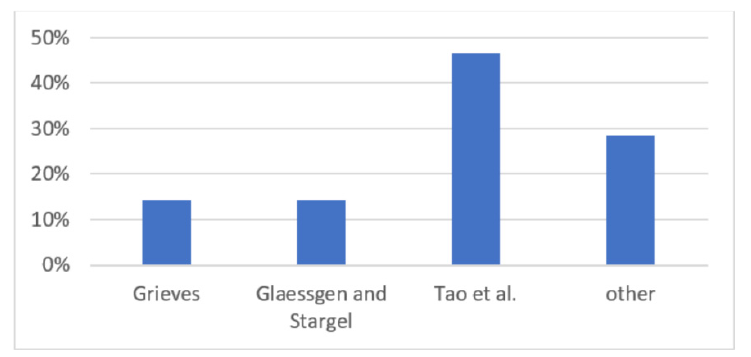
Figure 7. Definitions used for DTs.